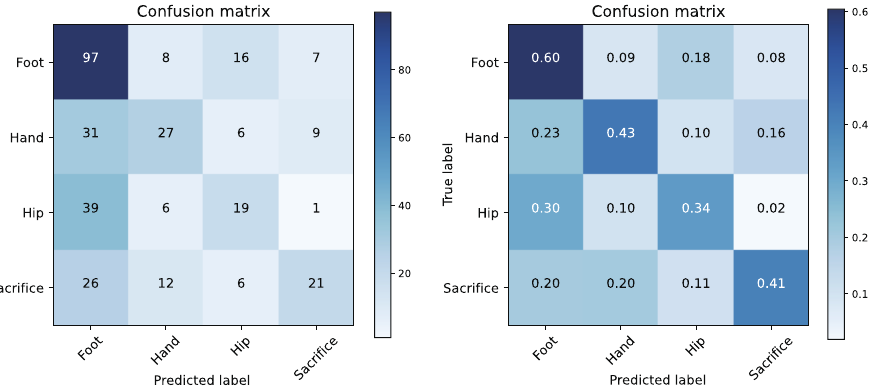
Figure 7. The number of cases (the matrix in the left ) and the F -values (the one in the right ) in confusion matrix when predicting the Kano’s classification for 287 scenes selected by men attribute from the standardized datasets (accuracy 0.5347432024169184).